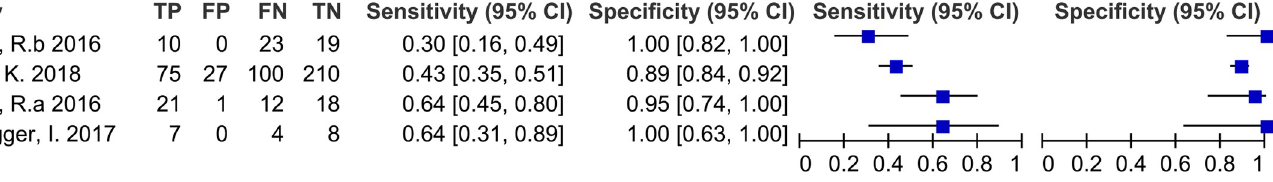
Fig 4. Forest plot for the sensitivity and specificity of cell free DNA for the diagnosis of tuberculosis compared with culture.